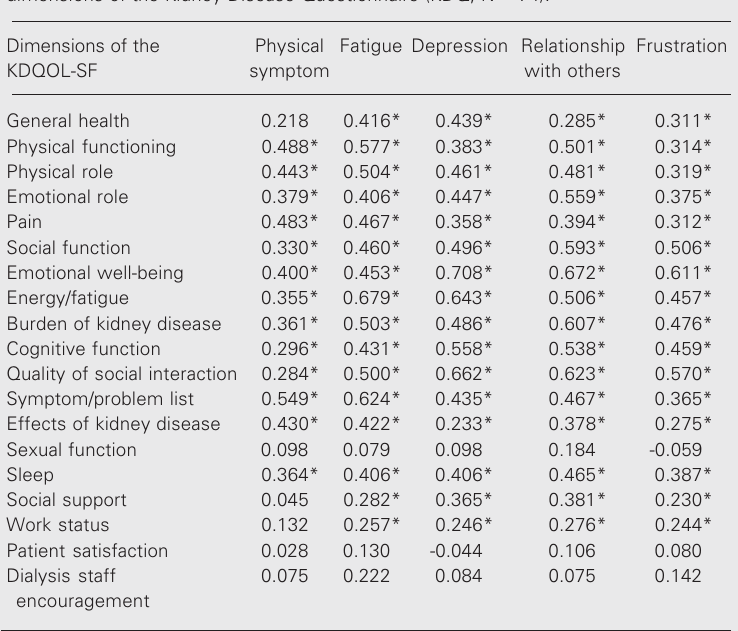
Table 6. Pearson’s correlation coefficient between the dimensions of the Brazilian Portuguese version of the Kidney Disease and Quality of Life - Short Form and the dimensions of the Kidney Disease Questionnaire (KDQ, N =